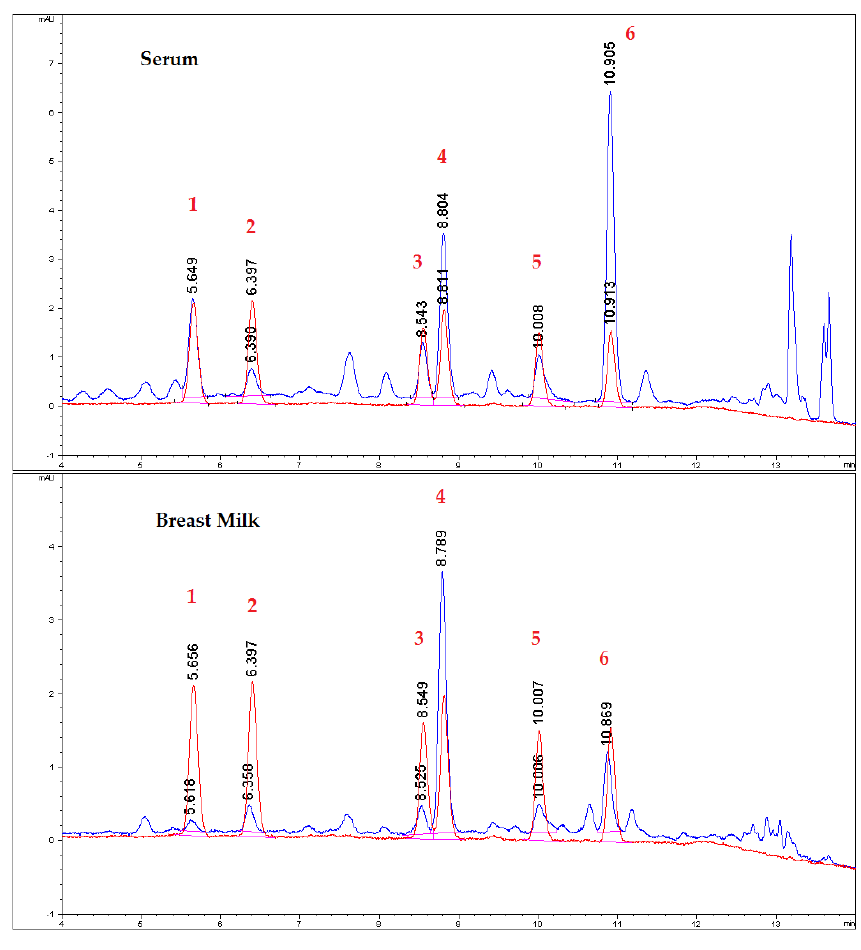
Figure 1. Typical chromatograms of standard (red trace) and sample (blue trace) shown in overlaid pattern. Peaks: ( 1 ) all- trans -lutein; ( 2 ) zeaxanthin; ( 3 ) β -cryptoxanthin; ( 4 ) Internal standard; ( 5 ) α -carotene; ( 6 ) β -carotene.